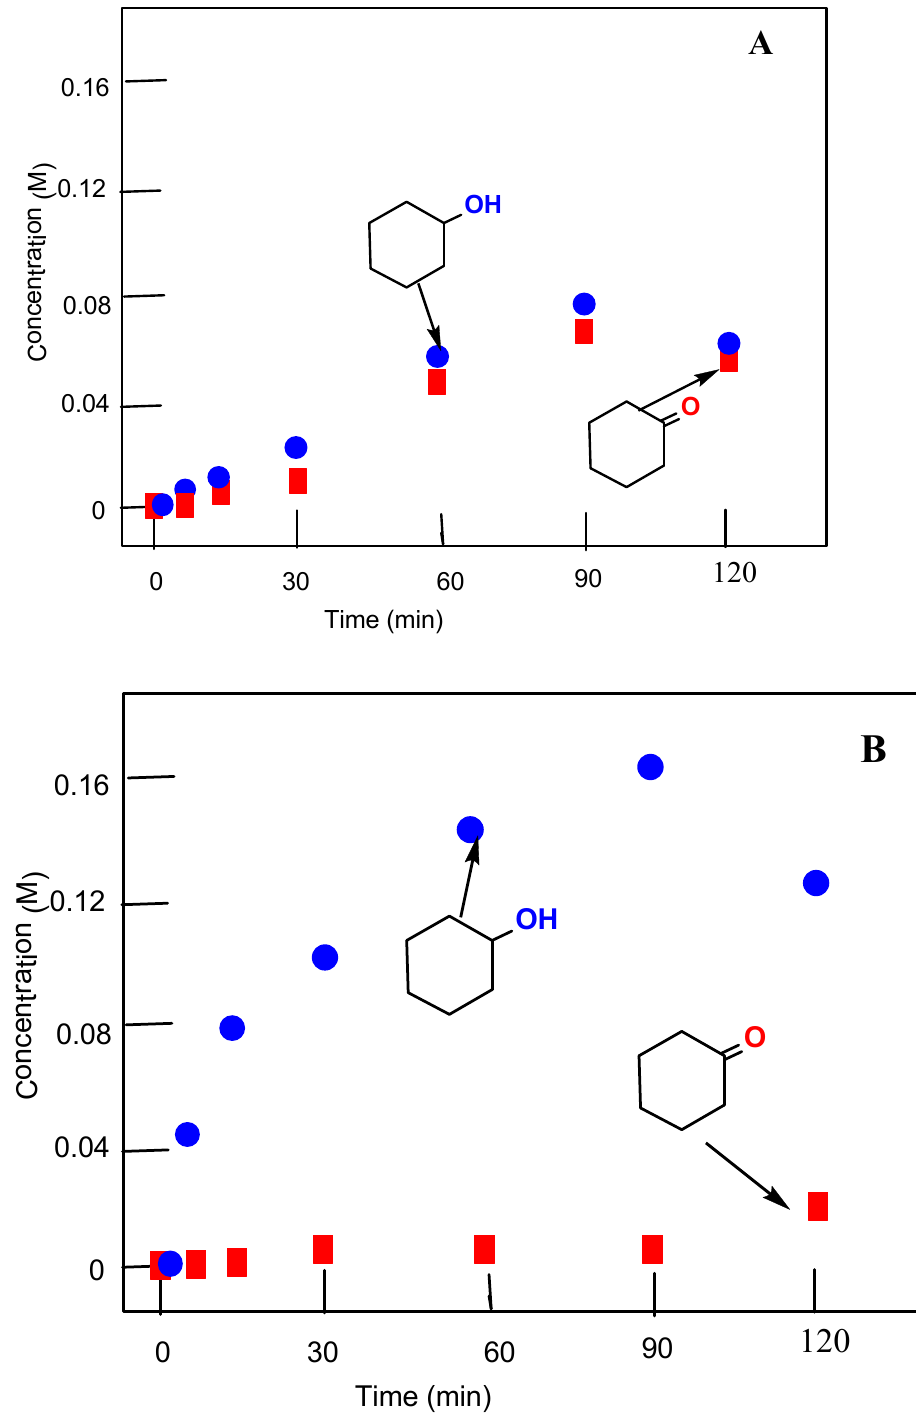
Figure 8. Accumulation of cyclohexanol and cyclohexanone in oxidation of cyclohexane (0.46 M) with hydrogen peroxide (2.0 M, 50% aqueous) catalyzed by compound 4 (5 × 10 − 4 M) in the presence of HNO 3 (0.05 M) in MeCN at 50 ◦ C. Concentrations of cyclohexanone and cyclohexanol were determined before reduction of the PPh 3 (Graph A ), and the same reaction after reduction of the aliquots with solid PPh 3 (Graph B ).